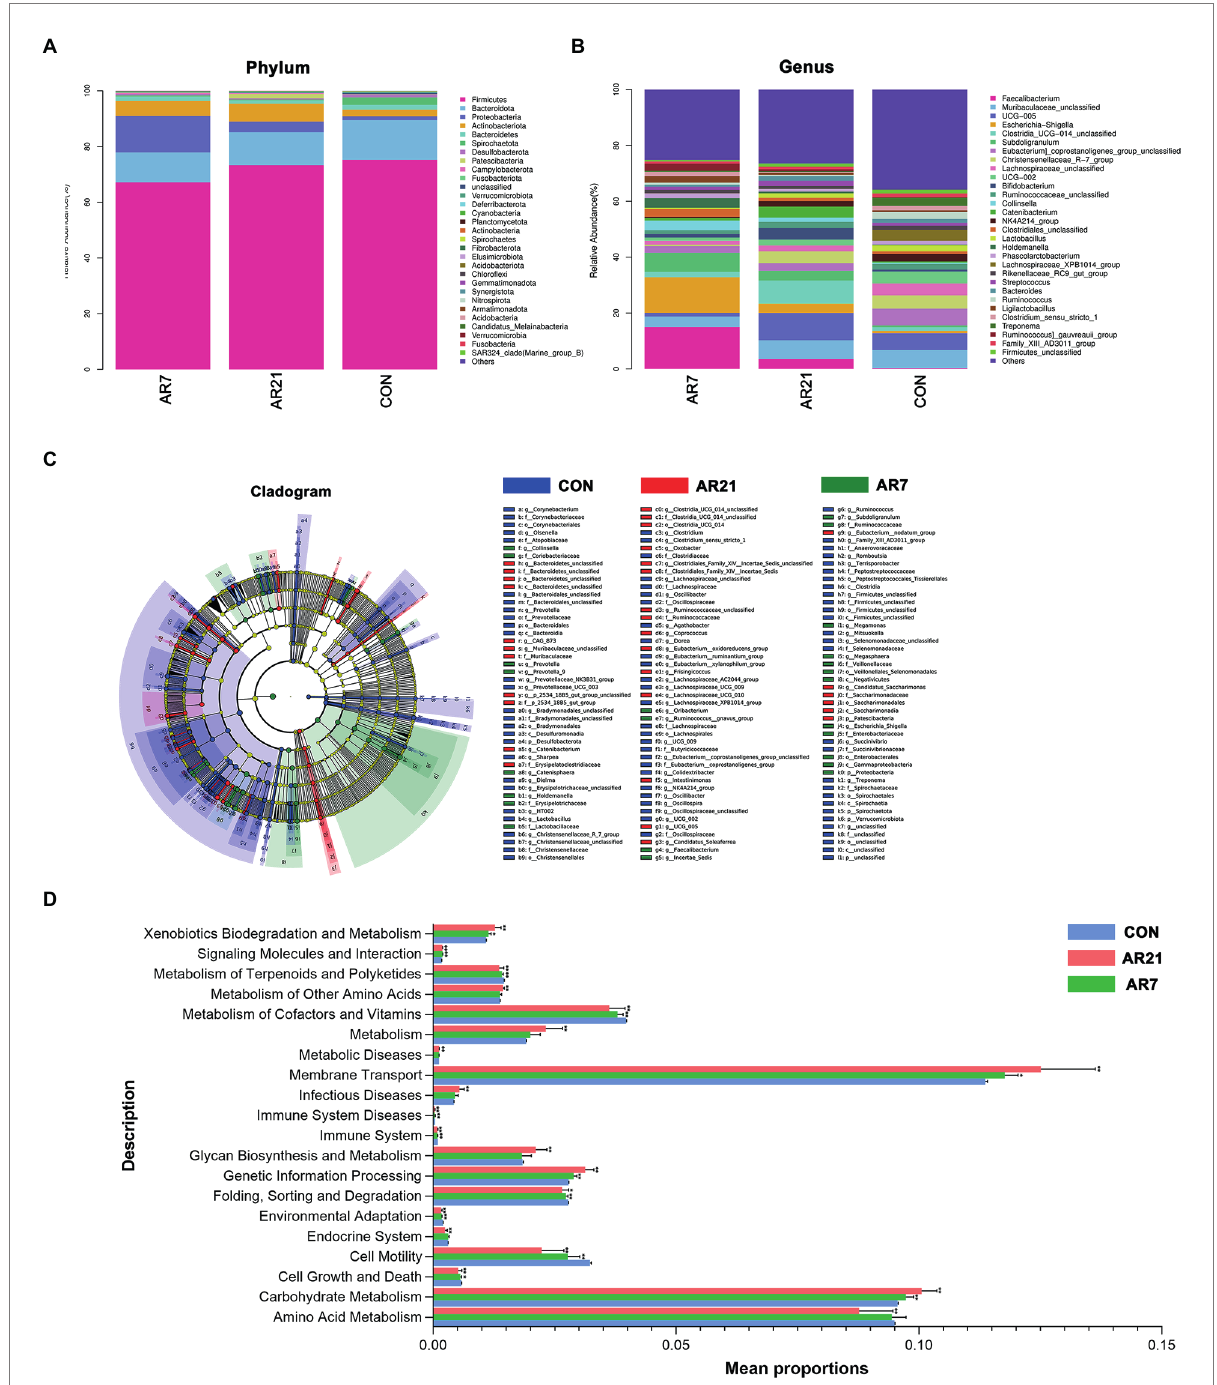
FIGURE 3 Effects of artificial rearing on the structure and function of colonic microbiota in piglets. (A) Relative abundance of microbiota at the phylum level. (B) Relative abundance of microbiota at the genus level. (C) Cladogram of enriched taxa based on linear discriminant analysis effect size (LEfSe) analysis. (D) Differences in bacterial function at Kyoto Encyclopedia of Genes and Genomes (KEGG) level 2 using PICRUSt2. Data are presented with mean ± SD. * p < 0.05 versus the CON group; ** p < 0.01 versus the CON group. n = 10